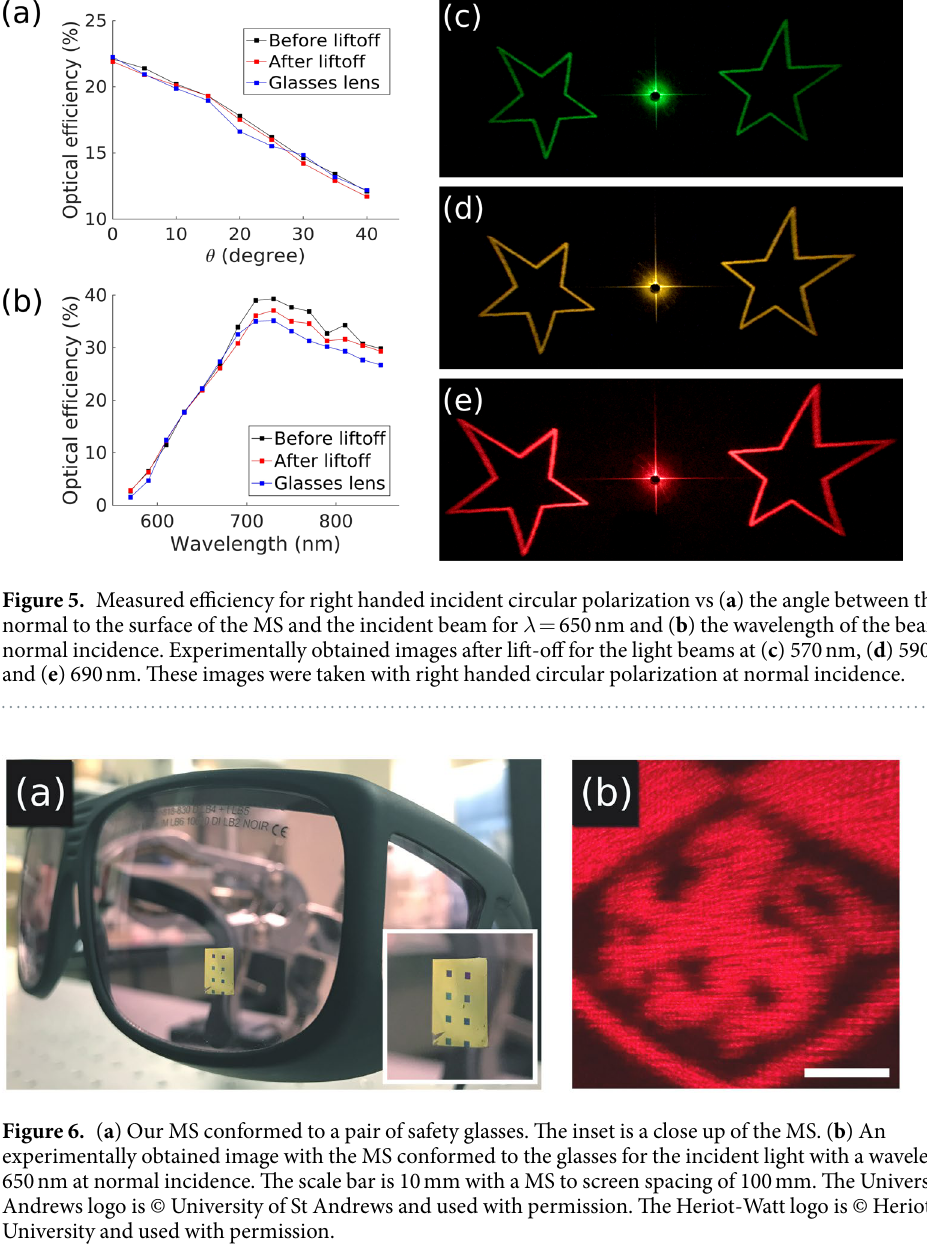
holographic efficiency. At wavelengths far from 730 nm the dimensions of the nanorods, and the thickness of the spacing layer, are not optimized to produce the π phase change and so this efficiency decreases. Furthermore, at shorter wavelengths the interband transitions in gold cause excessive absorption. This reduces the efficiency of the device to the point that holographic images cannot be seen much below 570 nm. Despite this limitation we